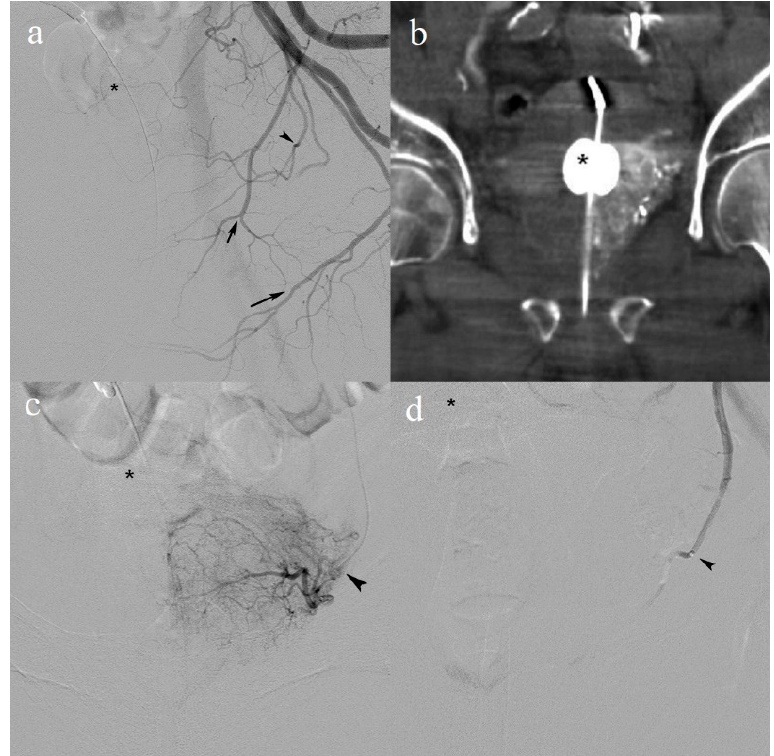
Figure 1. ( a ) Selective digital subtraction angiography (DSA) in the left anterior oblique position with the catheter tip in the left internal iliac artery (not visible). The internal pudendal artery (long arrow) and the characteristic division of obturator artery (short arrow). The prostate artery (arrowhead) protrudes beneath the Foley balloon (*) catheter; ( b ) coronal cone-beam computed tomography with contrast enhancement in the left lobe confirming correct catheter placement; ( c ) frontal DSA before embolization with injection on the microcatheter in the prostate artery (arrowhead); ( d ) frontal DSA with the microcatheter in the same position (arrowhead) and the angiographic endpoint after embolization.